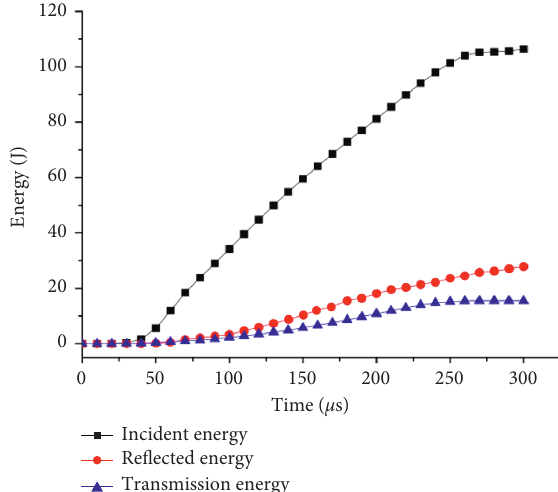
Figure 8: Energy evolution of nondestructive sandstone.